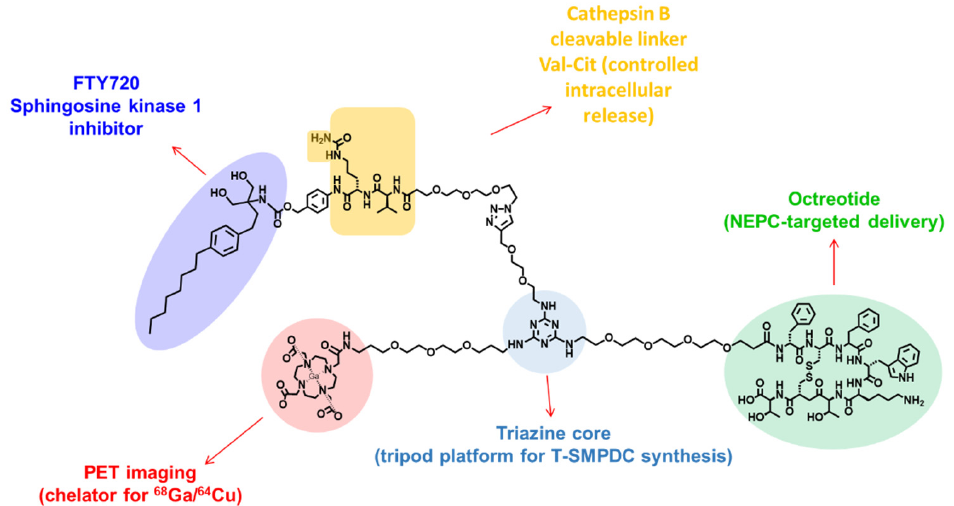
Figure 1. Design of a neuroendocrine prostate cancer (NEPC)-targeted chemotheranostic prodrug conjugate, DOTA-PEG 3 -TZ(PEG 4 -Octr)-PEG 2 -Trz-PEG 3 -Val-Cit-pABOC-FTY720. DOTA: 1,4,7,10- tetraazacyclododecane-1,4,7,10-tetraacetic acid; PEG n : polyethylene glycol chain with n repeating ethyleneoxy units (n = 2, 3, or 4); TZ: 1,3,5-triazine; Octr: octreotide; Trz: 1,4-disubstituted 1,2,3- triazole; Val: valine; Cit: citrulline; pABOC: p-amino-benzyloxycarbonyl; FTY720: fingolimod; T-SMPDC: theranostic small-molecule prodrug conjugate. The T-SMPDC, DOTA-PEG 3 -TZ(PEG 4 -Octr)-PEG 2 -Trz-PEG 3